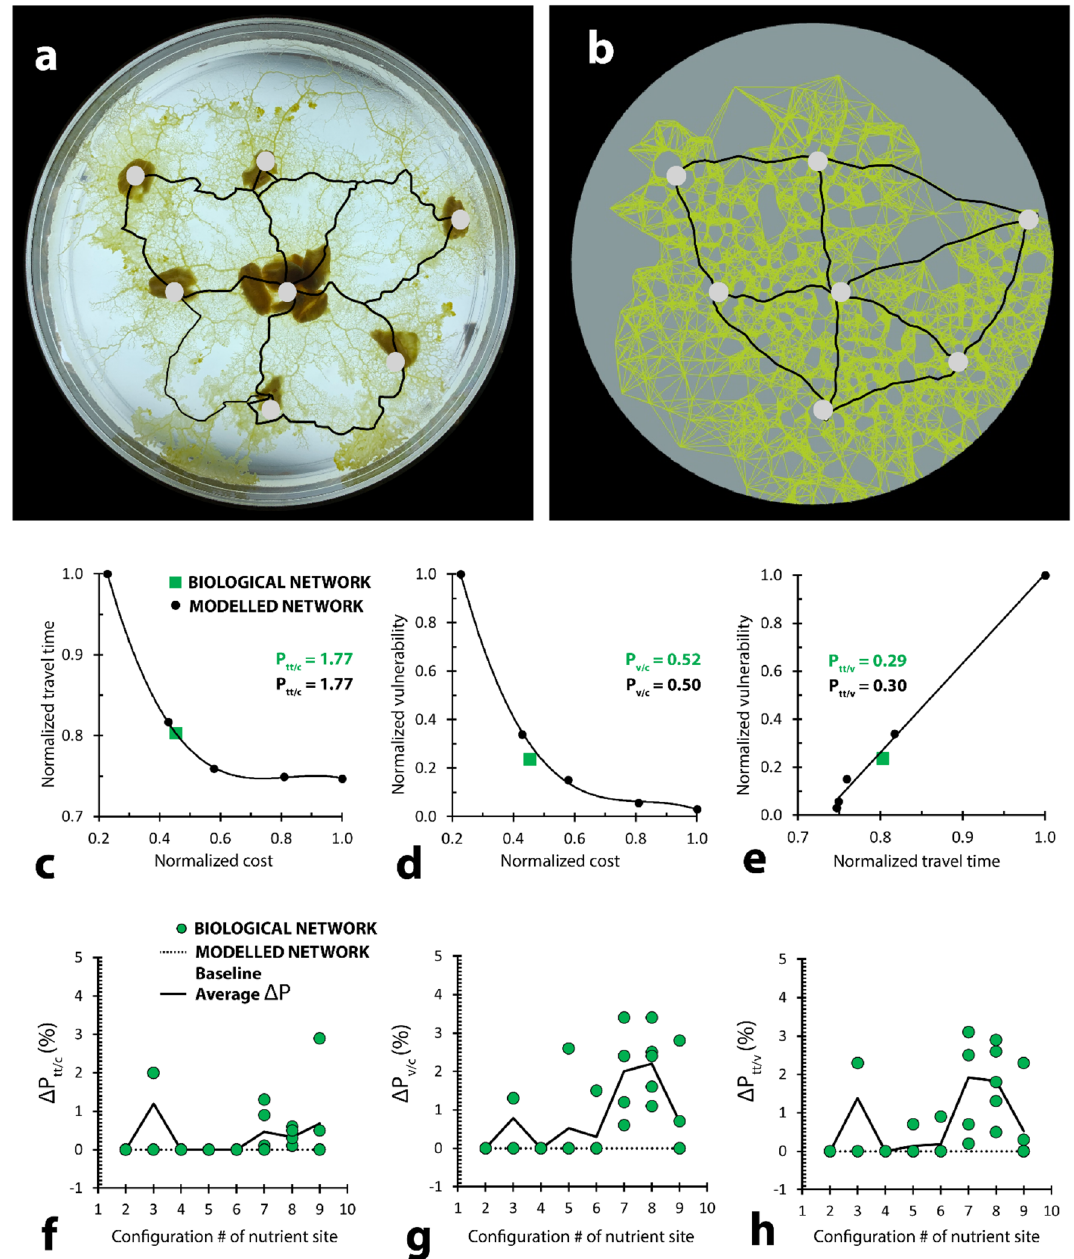
Figure 5. Performance of the modelled networks is within 4% of the performance of the biological networks. ( a ) Grown Physarum mesh with overlaid network (t = 5 days). ( b ) Modelled Physarum mesh with overlaid network. ( c ) Plot relating network cost to travel time for both grown (green) and modelled (black) networks. Trendline is a third-order polynomial function. ( d ) Plot relating network cost to vulnerability for both grown (green) and modelled (black) networks. Trendline is a third-order polynomial function. ( e ) Plot relating network travel time to vulnerability for both grown (green) and modelled (black) networks. Trendline is a linear function. All performance values normalized to the largest value. Modelled performance values displayed on the plots represent performance for the closest modelled point to the grown point (green) along the trendline. ( f–h ) Performance differences across multiple attractor patterns and growth repeats between biological and modelled networks are consistently within 4% of one another. Green dots represent grown networks. Smooth black lines represent average performance differences between all grown and modelled networks at each oat layout, where difference is taken between the grown network point to the closest point along the modelled network curve. P tt/c is the network travel time over the network cost; P v/c is the network vulnerability over the network cost; P v/tt is the network vulnerability over the network travel time. Plots displayed in c-e represent data from oat layout